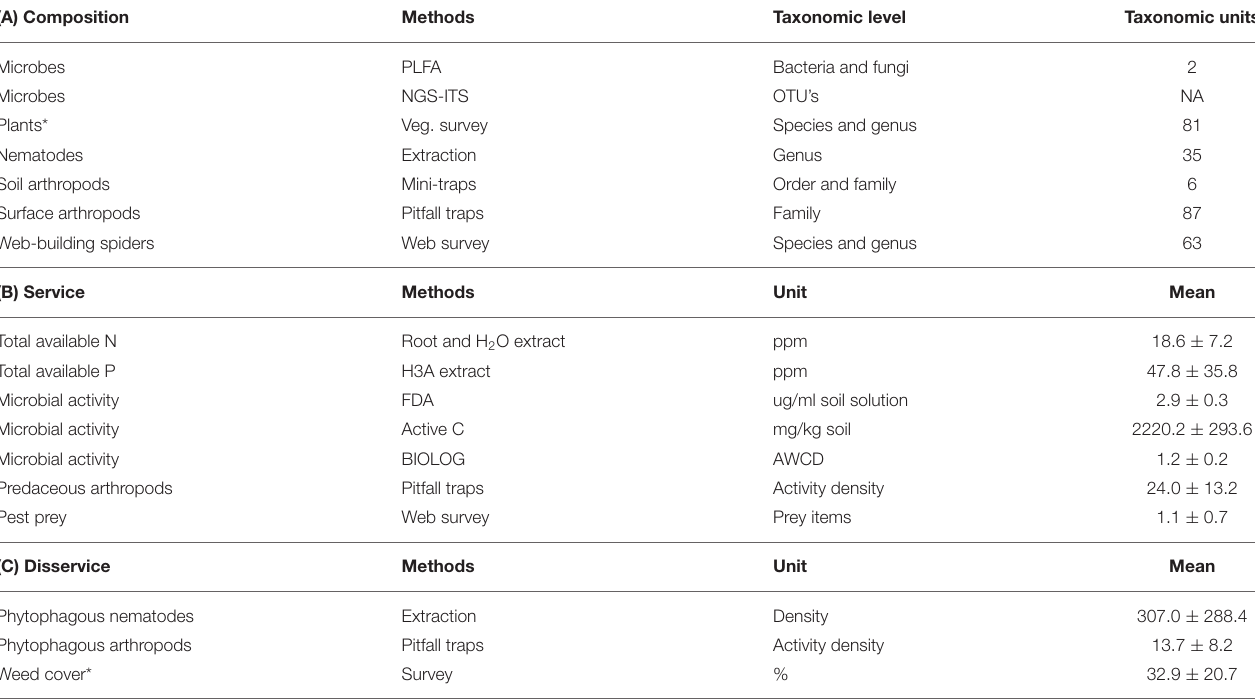
TABLE 2 | Summary of (A) community composition, (B) ecosystem service, and (C) disservice potentials quantified in organically (apricot, peach, plum, and quince) and conventionally (apricot) managed orchards with the respective methods, taxonomic level (community composition) or unit of measure (service and disservice) and number of taxa or mean and standard